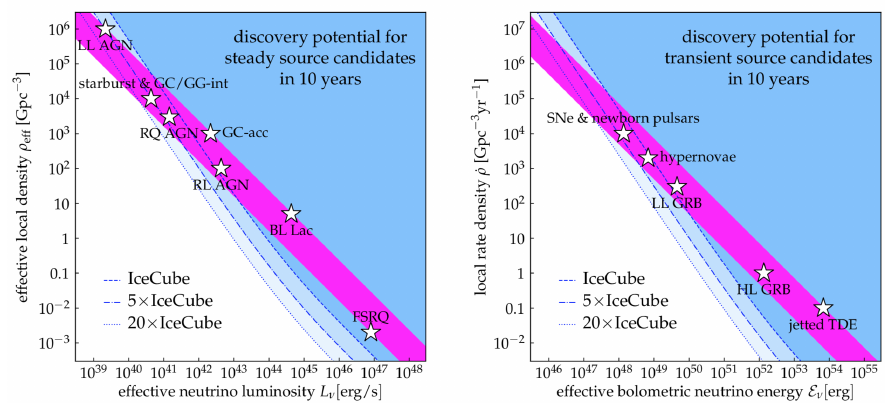
Figure 12. Figure from Reference [108]. The purple bands show the power required to interpret the flux of astrophysical neutrinos detected by IceCube (steady sources on the left, transient sources on the right). The blue regions show the parameter space excluded by the absence of multiplets in the neutrino data (i.e., two or more events from the same source). Sources that are abundant and faint (top left of the panels) are favorite by the